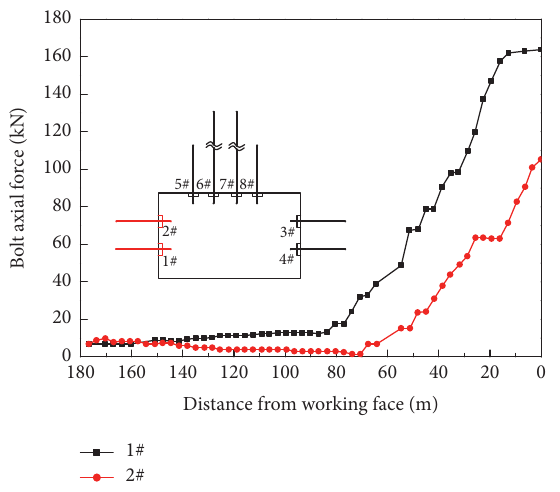
Figure 16: Nonhydraulic fracturing section: stress of side bolt of coal pillar at 5# station.